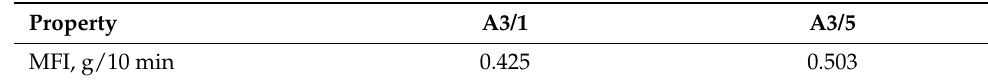
Table 11. MFI values of A3/1 and A3/5